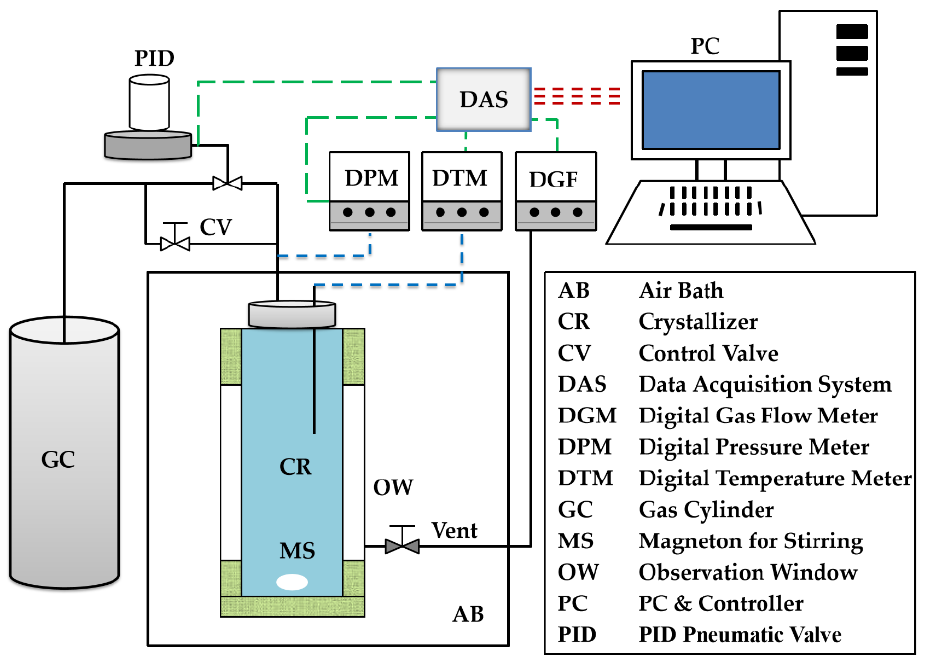
Figure 1. Schematic of the experimental system.